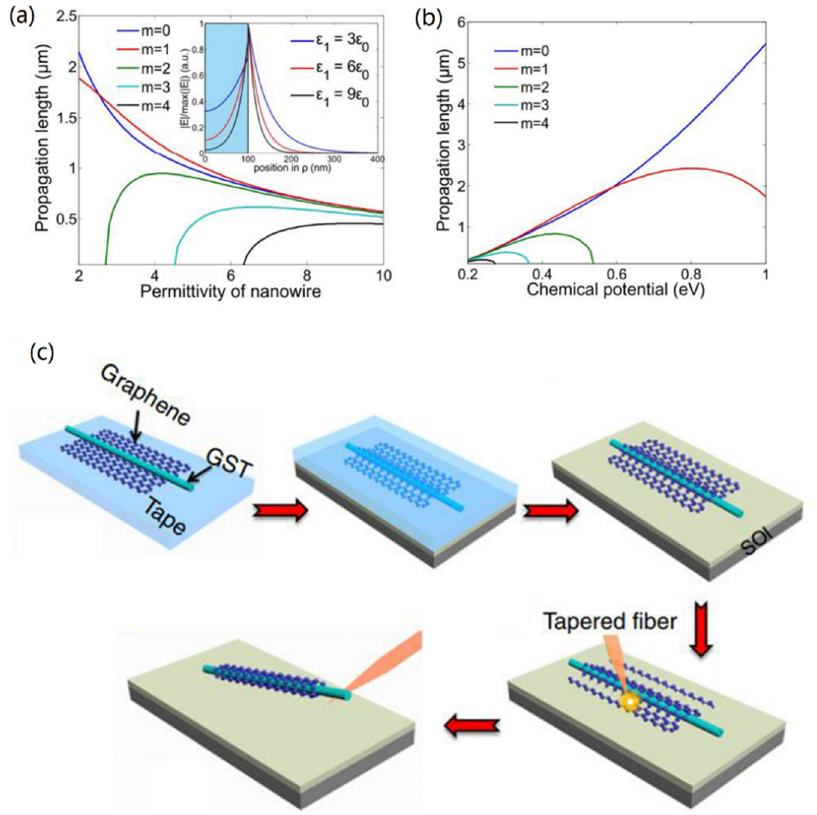
Figure 3. Propagation length as functions of nanowire permittivity ( a ) and chemical potential ( b ) at 30 THz with R = 100 nm. Reprinted with permission from reference [30]. Copyright Optical Society of America, 2014. ( c ) Schematic illustration of the GCNW fabrication process. Reprinted with permission from reference [46]. Copyright Springer Nature, 2018.